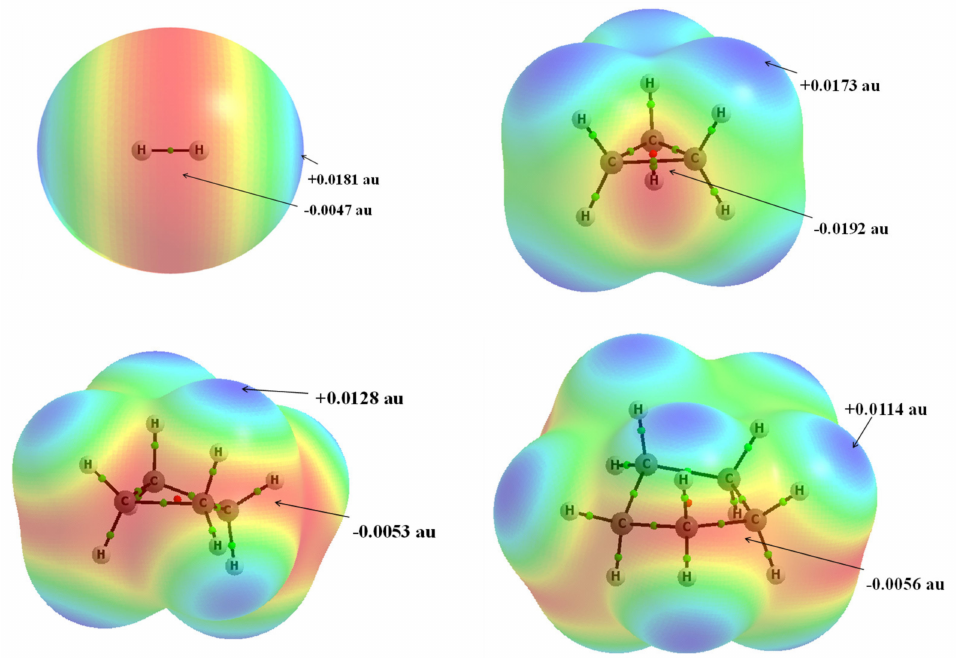
Figure 6. Molecular graphs of H 2 , C 3 H 6 , C 4 H 8 and C 5 H 10 molecules: small green circles correspond to the bond critical points; the EP surfaces characterised by the 0.001 au electron density are pre- sented; blue colour corresponds to the maximum positive EP; red colour corresponds to the negative minimum EP; and the scale of colours concerns each of the molecules separately. According to left-to-right and top-to-bottom order, the following molecules are presented: H 2 , C 3 H 6 , C 4 H 8 and C 5 H 10